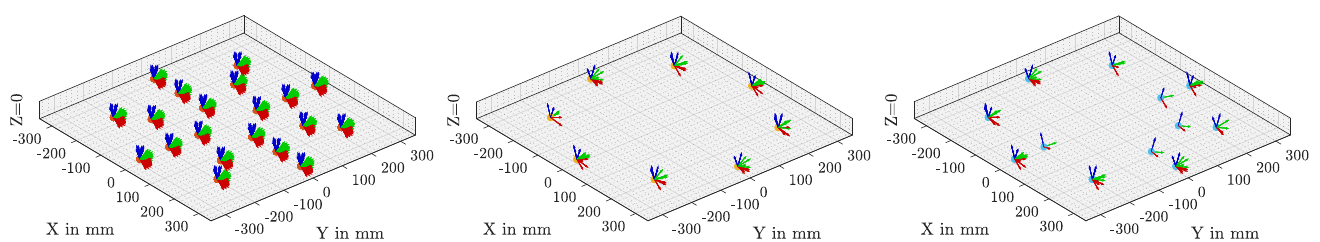
Figure 4. Poses for quasi-static parameter identification in the Cartesian workspace, left : original dataset with 480 poses (Q5M); centre and right : reduced datasets (30 poses each) after optimization with A (Q5A) and N (Q5N) criteria,